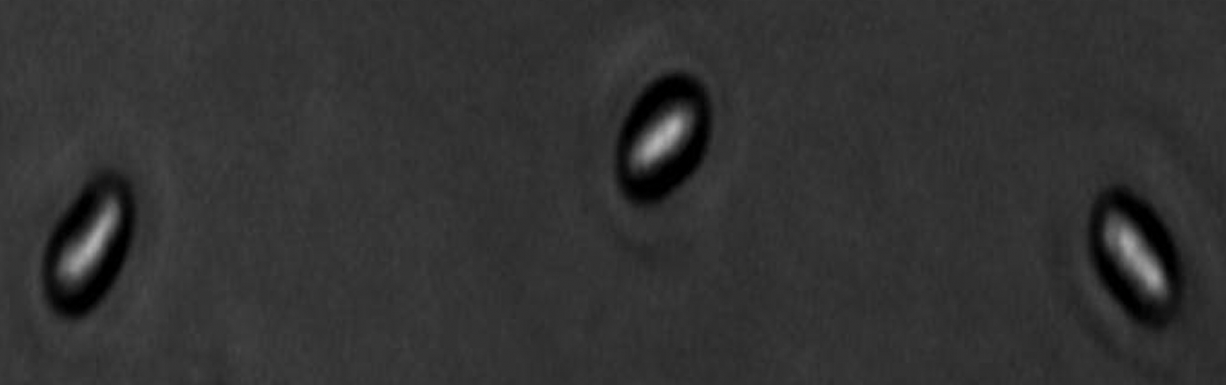
Fig 1. Picture of the capsulated sperm cells from P . ornata captured under a microscope (40x). Photo: MJ Albo.